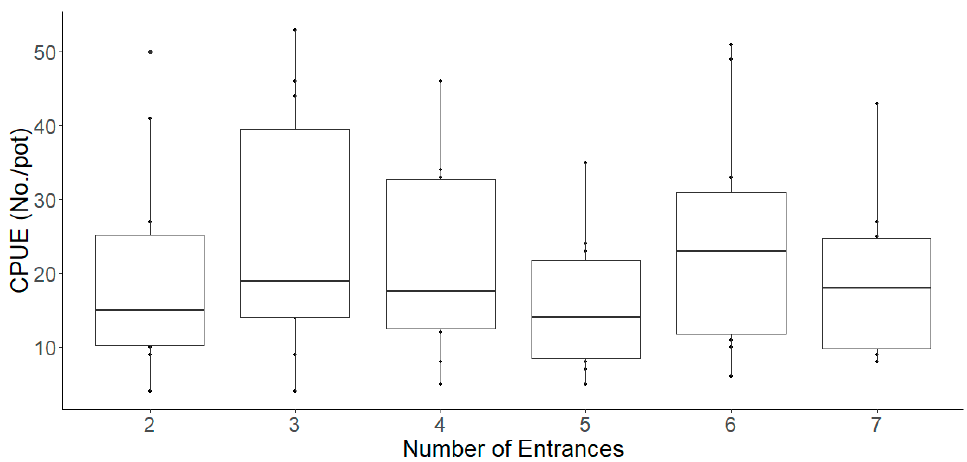
Figure 3. Number of crayfish captured using 6 different traps varying in entrance numbers. Horizontal line within each box represents the median. Lower and upper hinges of the boxes represent the first and third quartile, respectively. Lower and upper whiskers depict scores outside the interquartile range. Black dots correspond to the outliers.